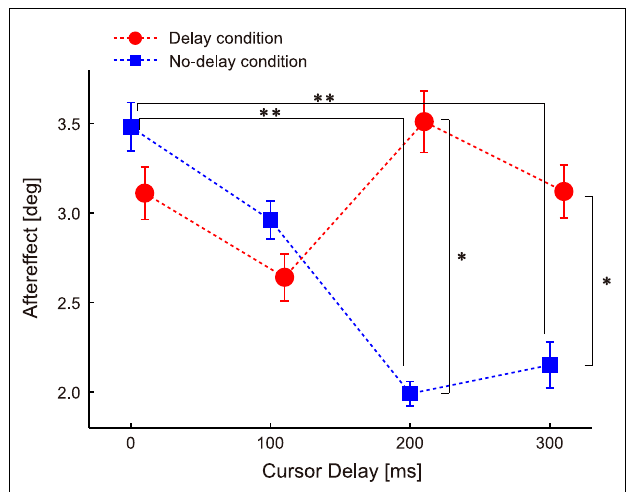
FIGURE 3 |Aftereffect of ± 10˚ visuomotor rotation. Data are sorted according to the cursor delay in their previous perturbation trials.The double asterisks illustrate the significant difference between cursor delays revealed by Ryan’s multiple comparison test conducted for the aftereffects in the no-delay condition .The single asterisks illustrate the significant main effect of condition revealed by one-way repeated measures ANOVA conducted for each cursor delay. Error bars indicate standard